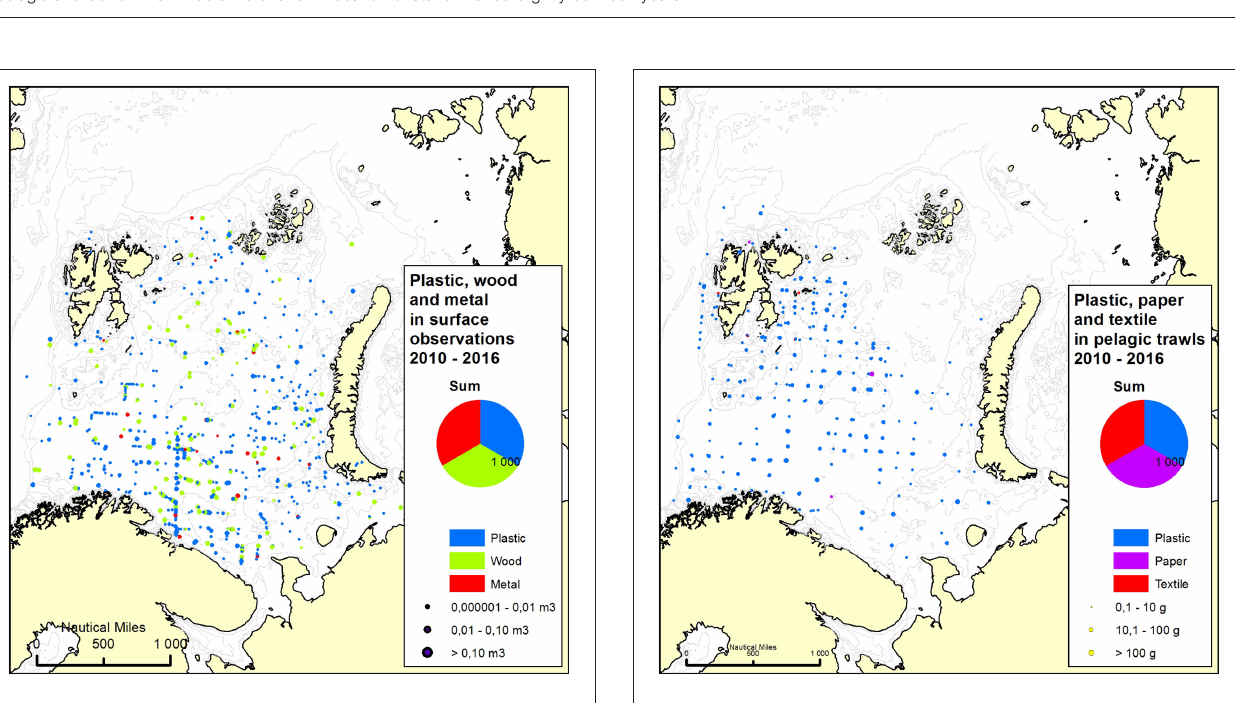
the Fisheries protection zone around Svalbard, and one to two Russian vessels cover the Russian economic zone. The indicated stations include a bottom trawl haul, a pelagic trawl haul